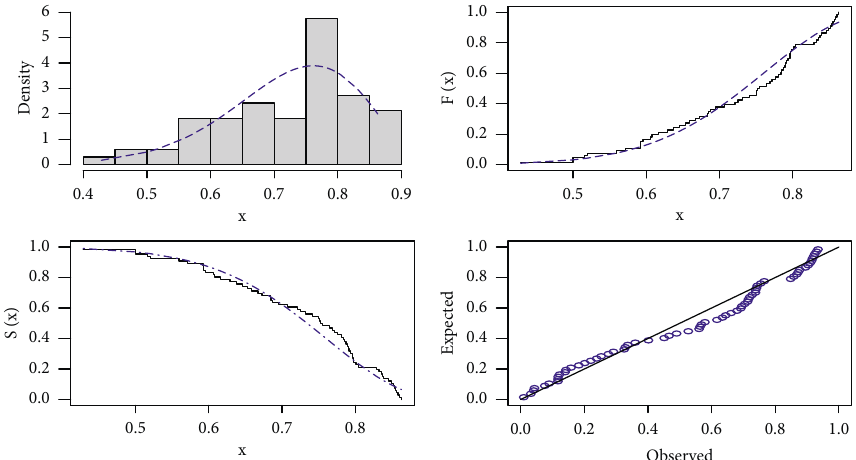
Figure 9: Histogram of the COVID-19 data set with the fitted PDF, CDF, SF, and P–P plots.